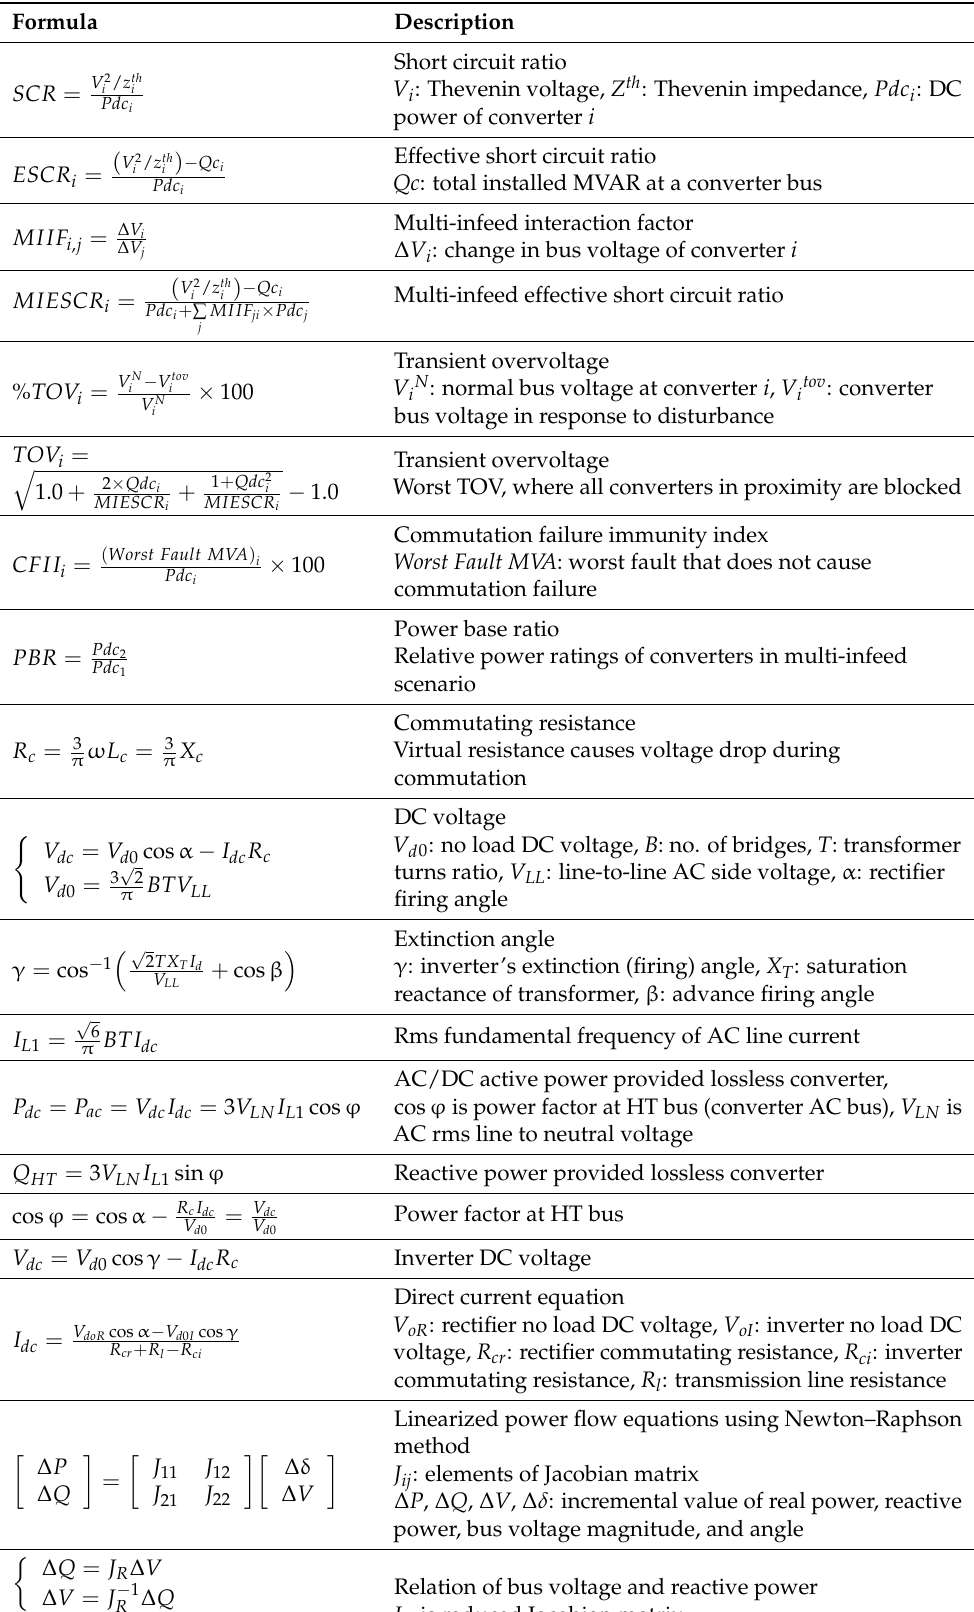
Table 1. Basic analytical expressions of a multi-infeed LCC–HVDC